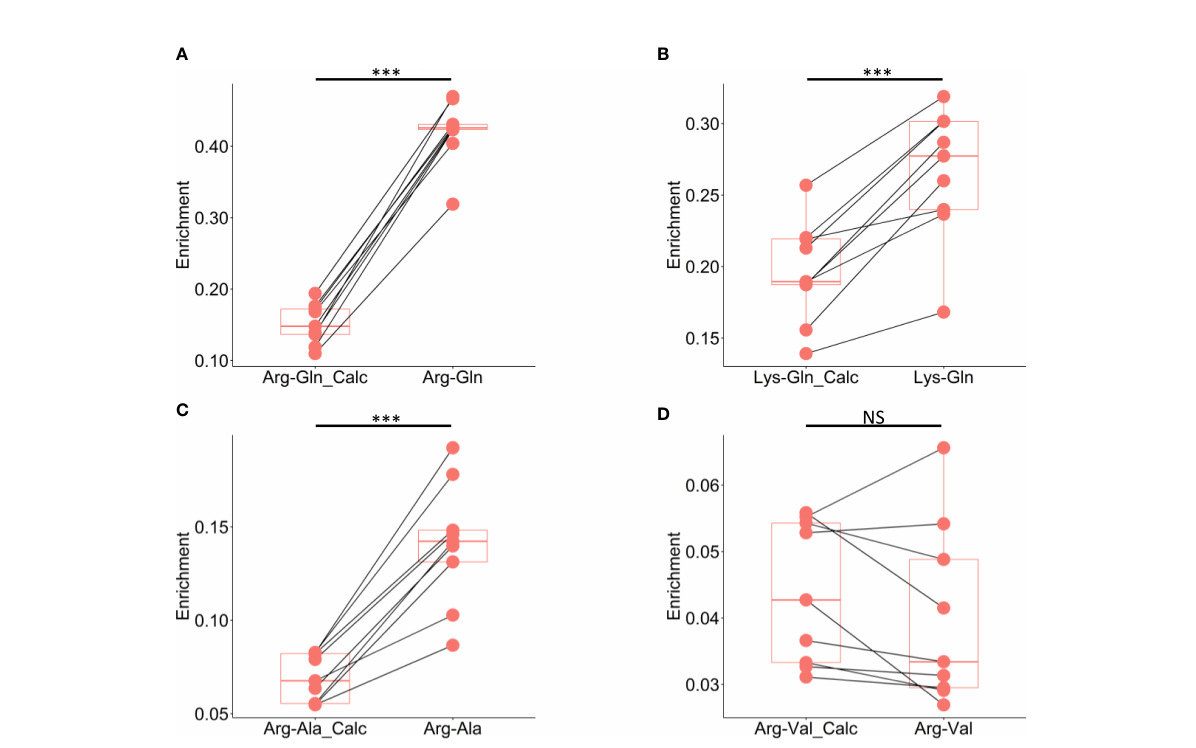
FIGURE 5 Comparison of calculated dipeptide and experimentally observed dipeptide enrichment in M. capitata . (A) Comparison of the calculated enrichment of arginine-glutamine based on the enrichments of the respective constitutive amino acids to the experimentally measured enrichment of arginine-glutamine pool directly. (B) Comparison of the calculated enrichment of lysine-glutamine based on the enrichments of the respective constitutive amino acids to the experimentally measured enrichment of lysine-glutamine pool directly. (C) Comparison of the calculated enrichment of arginine-alanine based on the enrichments of the respective constitutive amino acids to the experimentally measured enrichment of arginine-alanine pool directly. (D) Comparison of the calculated enrichment of arginine-valine based on the enrichments of the respective constitutive amino acids to the experimentally measured enrichment of arginine-valine pool directly. Asterisks denote signi fi cance at *P <0.05, **P <0.01, ***P <0.001, and NS denotes result is not signi fi